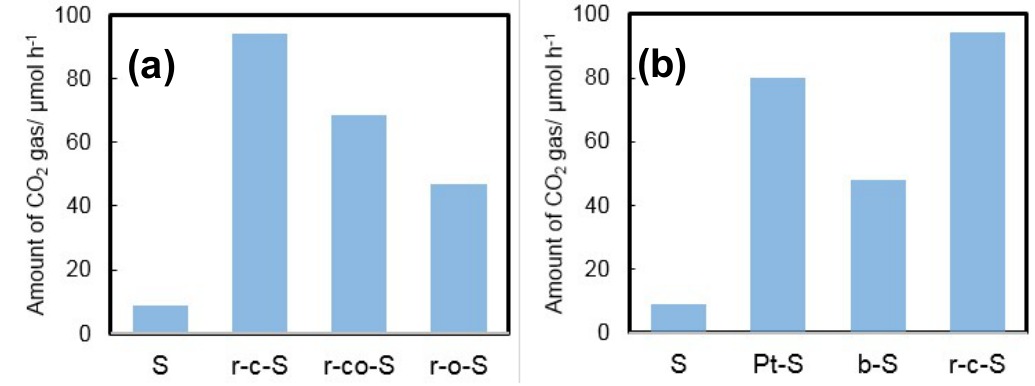
Figure 7. ( a ) Photocatalytic activity of titania (ST-G2) and FCP-loaded titania in a CO 2 system; ( b ) Photocatalytic activity of titania, Pt-loaded titania (denoted as Pt-S), Pt-unloaded Cu 2 O-loaded titania (denoted as b-S) and FCP-loaded titania in a CO 2 system.